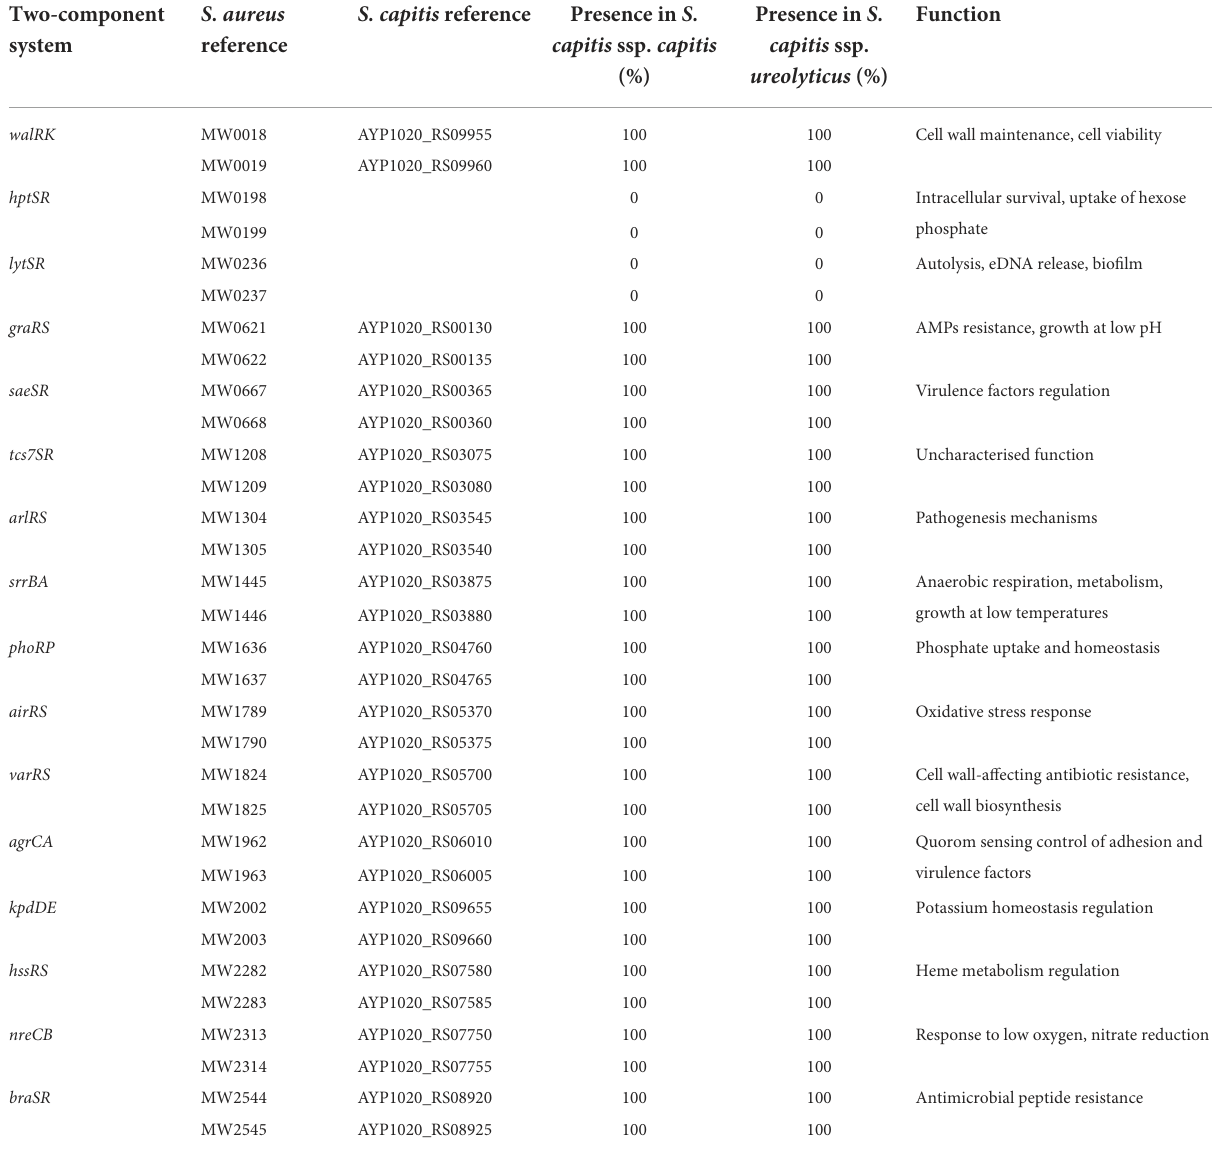
TABLE 1 Two-component systems in S. aureus and S. capitis .